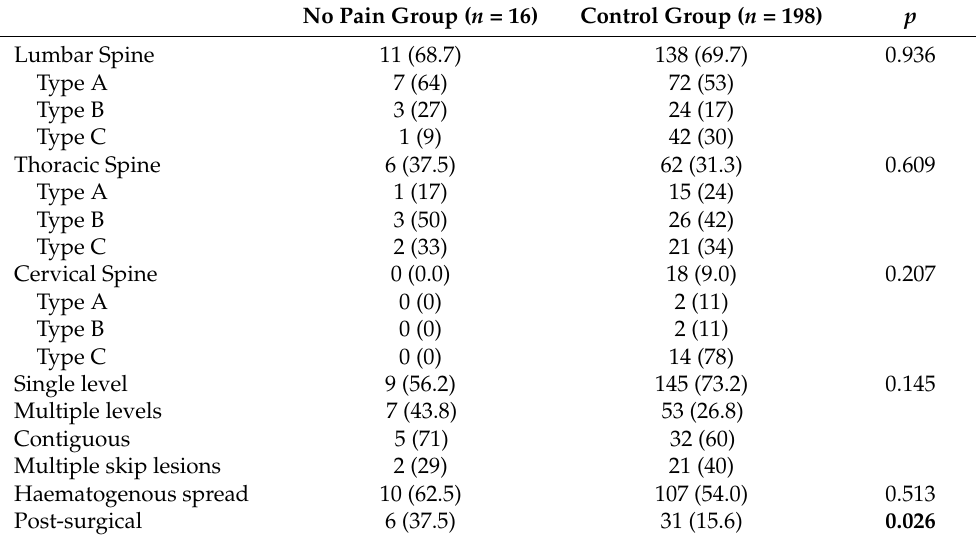
Table 2. Location and classification ( n ,